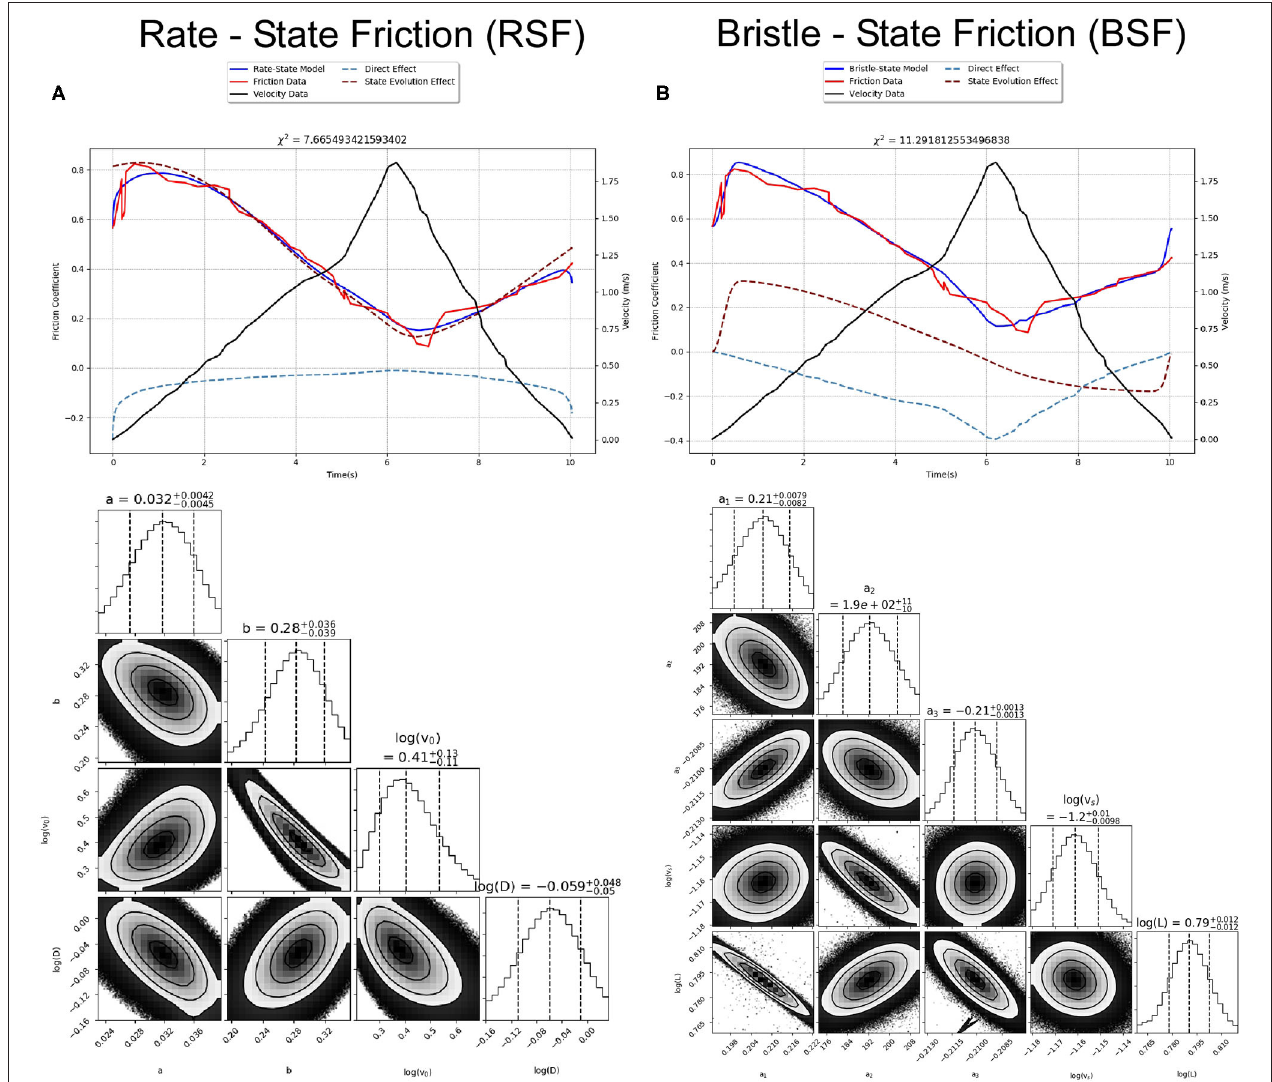
FIGURE 3 | Best-fitting models (same details as Figure 2 above) and MCMC posterior probability distribution corner plots are shown for fully flexible inversions of (A) RSF and (B) BSF. In order to best fit both terms on the plot with minimal overlap, they are offset. RSF doesn’t require an additional offset because µ 0 is part of the friction coefficient, but BSF the friction is only the sum of these two terms, so we use the initial friction coefficient ( µ (t = 0)) such that the initial values for each term is zero (thus the friction coefficient curve is a summation of the two terms, as they are plotted, plus this additional offset). The triangle plot shows the 1D and 2D projections of the posterior probability distributions of our model parameters. In the 1D plots, the vertical lines show median and the 1-sigma values of the parameters while the 2D histograms show the contour intervals for the 0.5, 1, 1.5, and 2 sigma levels 11.7, 39.3, 67.5, and 86.4% confidence intervals. Although the fully flexible RSF model achieves a slightly lower χ 2 , this includes digitization errors and visual inspection suggests BSF better fits the initial